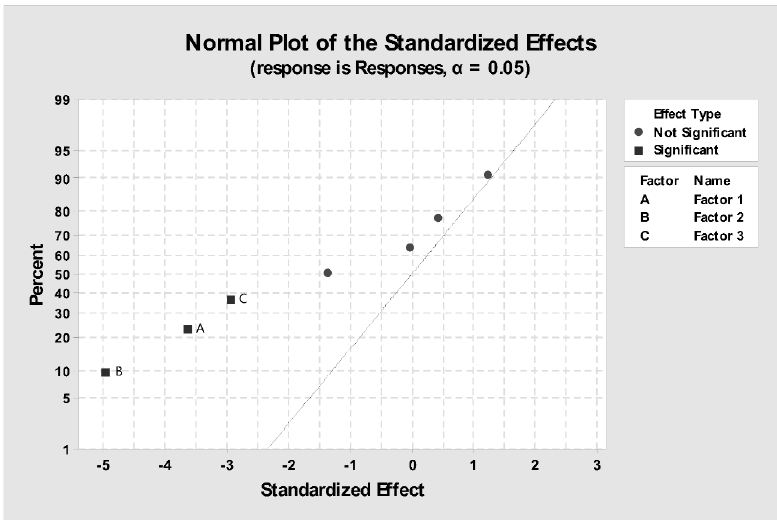
Figure 2 : Standardized effects for